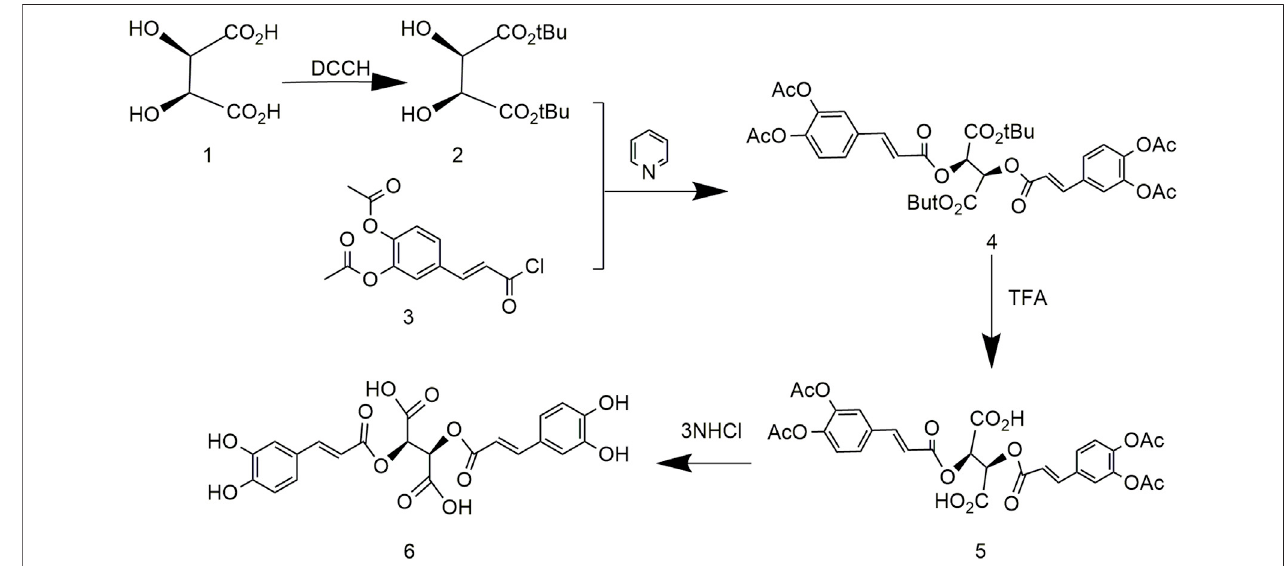
FIGURE 4 | Chemical synthesis pathway 2 of chicoric acid.